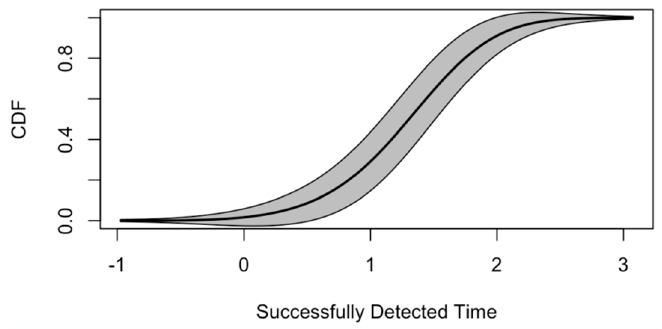
Figure 11. Lane-changes detected time (overall).